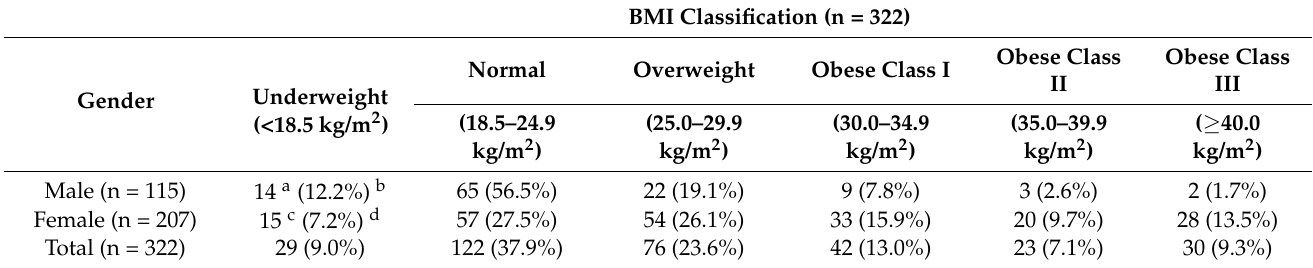
Table 3. Body mass index classification for adults ≥ 18 years (n =